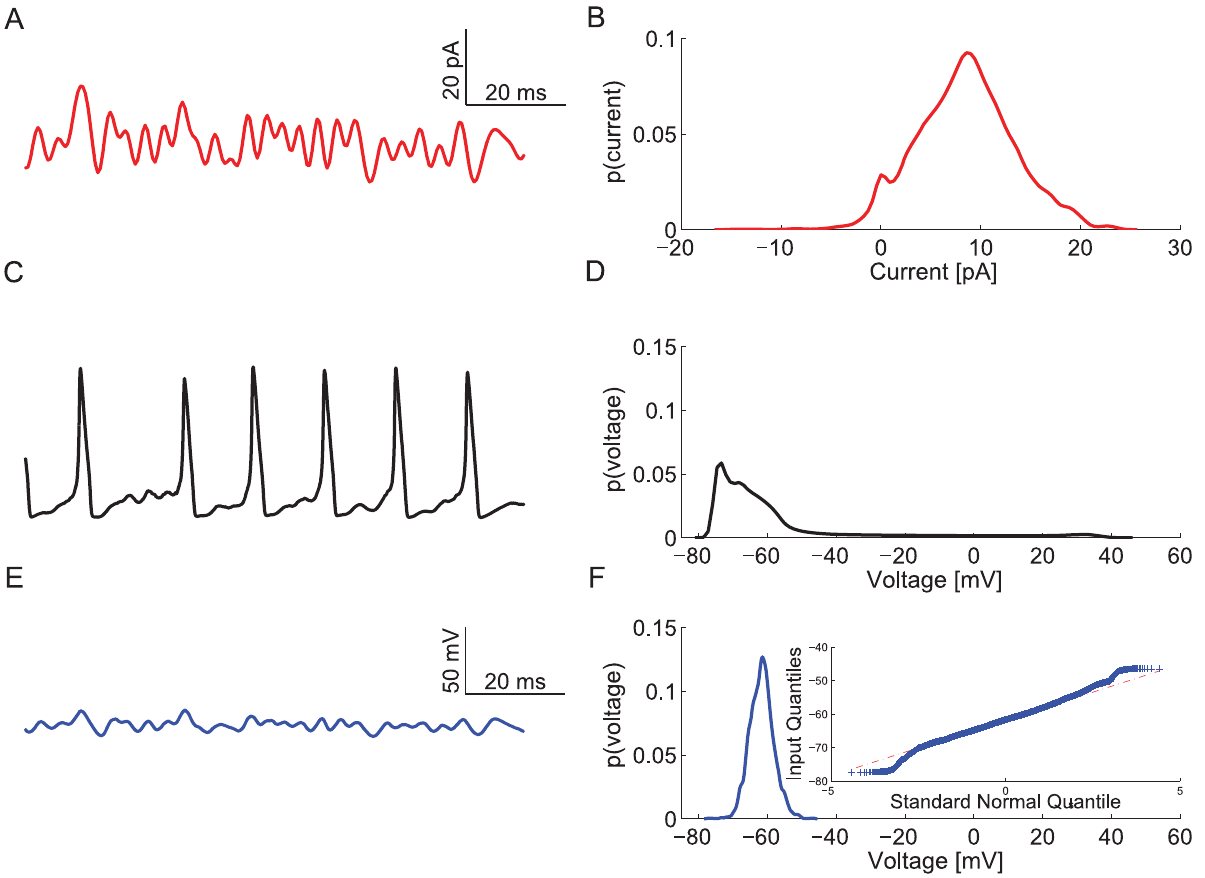
Figure 1. Voltage responses of spiking and graded potentials. A. The band-limited 300 Hz filtered Gaussian white noise current stimulus. B. The probably density function (PDF) of the current stimulus shown in A. C. A voltage response of the spiking neuron model to the current stimulus shown in A. D. The PDF of the spiking neuron model’s voltage response. E. A voltage response of the graded neuron model to the current stimulus shown in A. F. The PDF of the graded neuron model’s voltage response. (Inset) A QQ plot showing departures from a Gaussian distribution (dotted red-line) for the time-series shown in E.